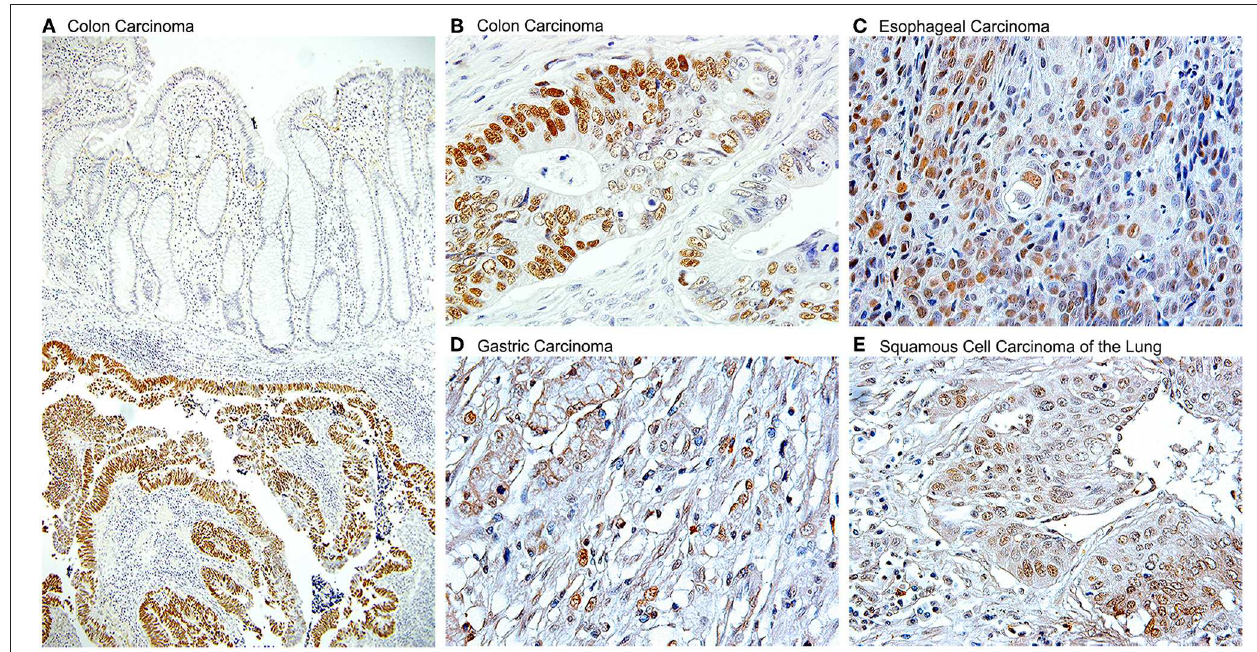
FIGURE 5 | Detection of JCPyV T-Antigen in various human tumors. Immunohistochemistry for the JCPyV early product, large T-Antigen shows robust expression in a variety of epithelial human cancers. (A) At low magnification, the expression of T-Antigen is evident in the submucosal tumor, however the suprajacent normal colonic epithelium is completely negative (Original magnification 100x). (B) At higher magnification, the majority, but not all neoplastic cells shown nuclear T-Antigen (Original magnification 600x). Other tumors in which T-Antigen is present are (C) esophageal carcinomas, (D) gastric carcinomas, and (E) non-small cell carcinomas of